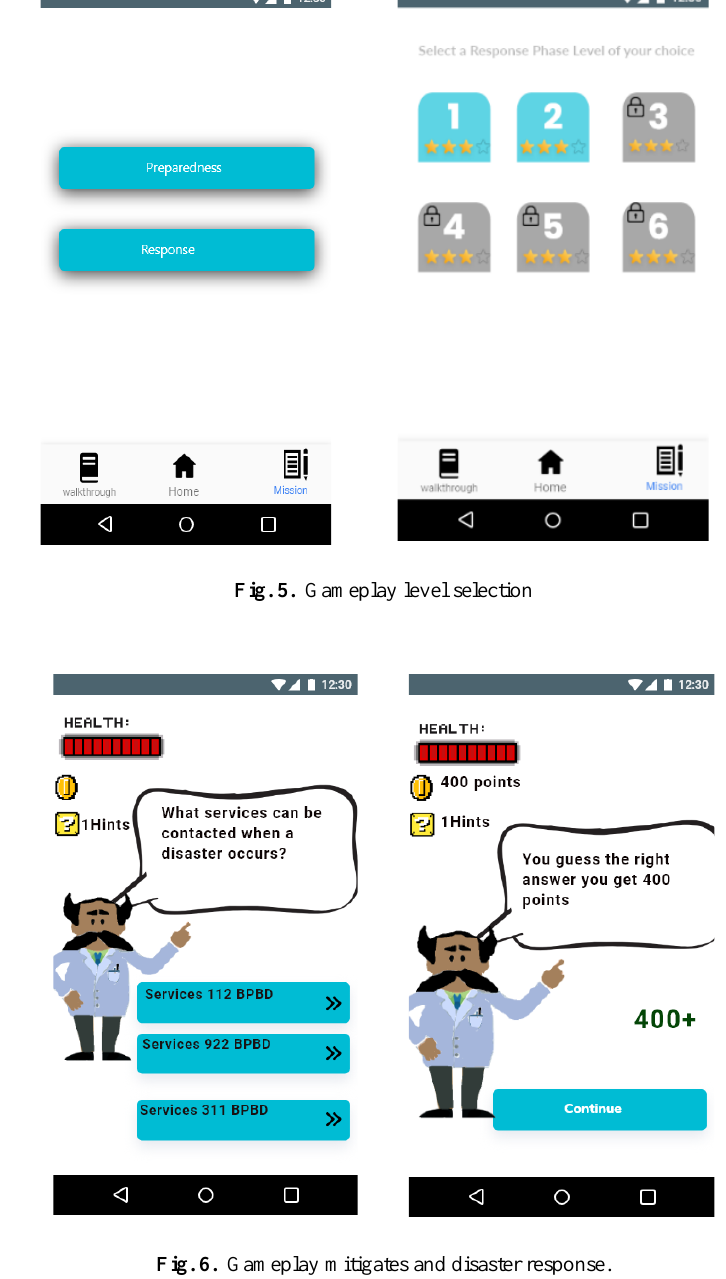
Fig. 6. Gameplay mitigates and disaster